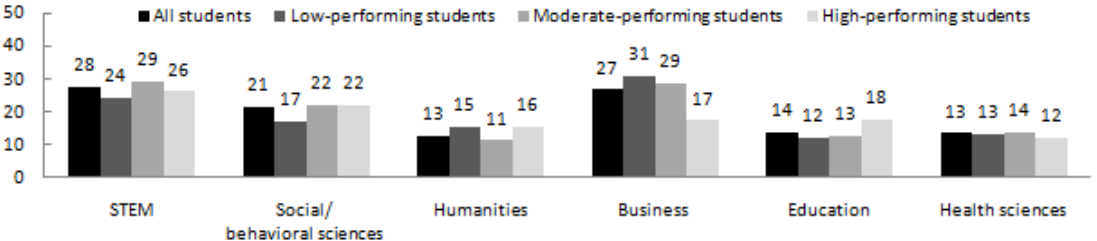
Figure 1. Percentage of students who entered STEM and selected non-STEM felds: